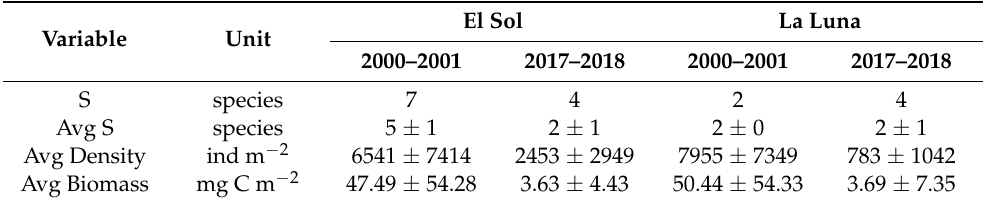
Table 3. Ecological variables (average ± standard deviation) of Lakes El Sol and La Luna, Nevado de Toluca, measured in 2000–2001 and 2017–2018 annual cycles. (S = species richness, Avg = average).